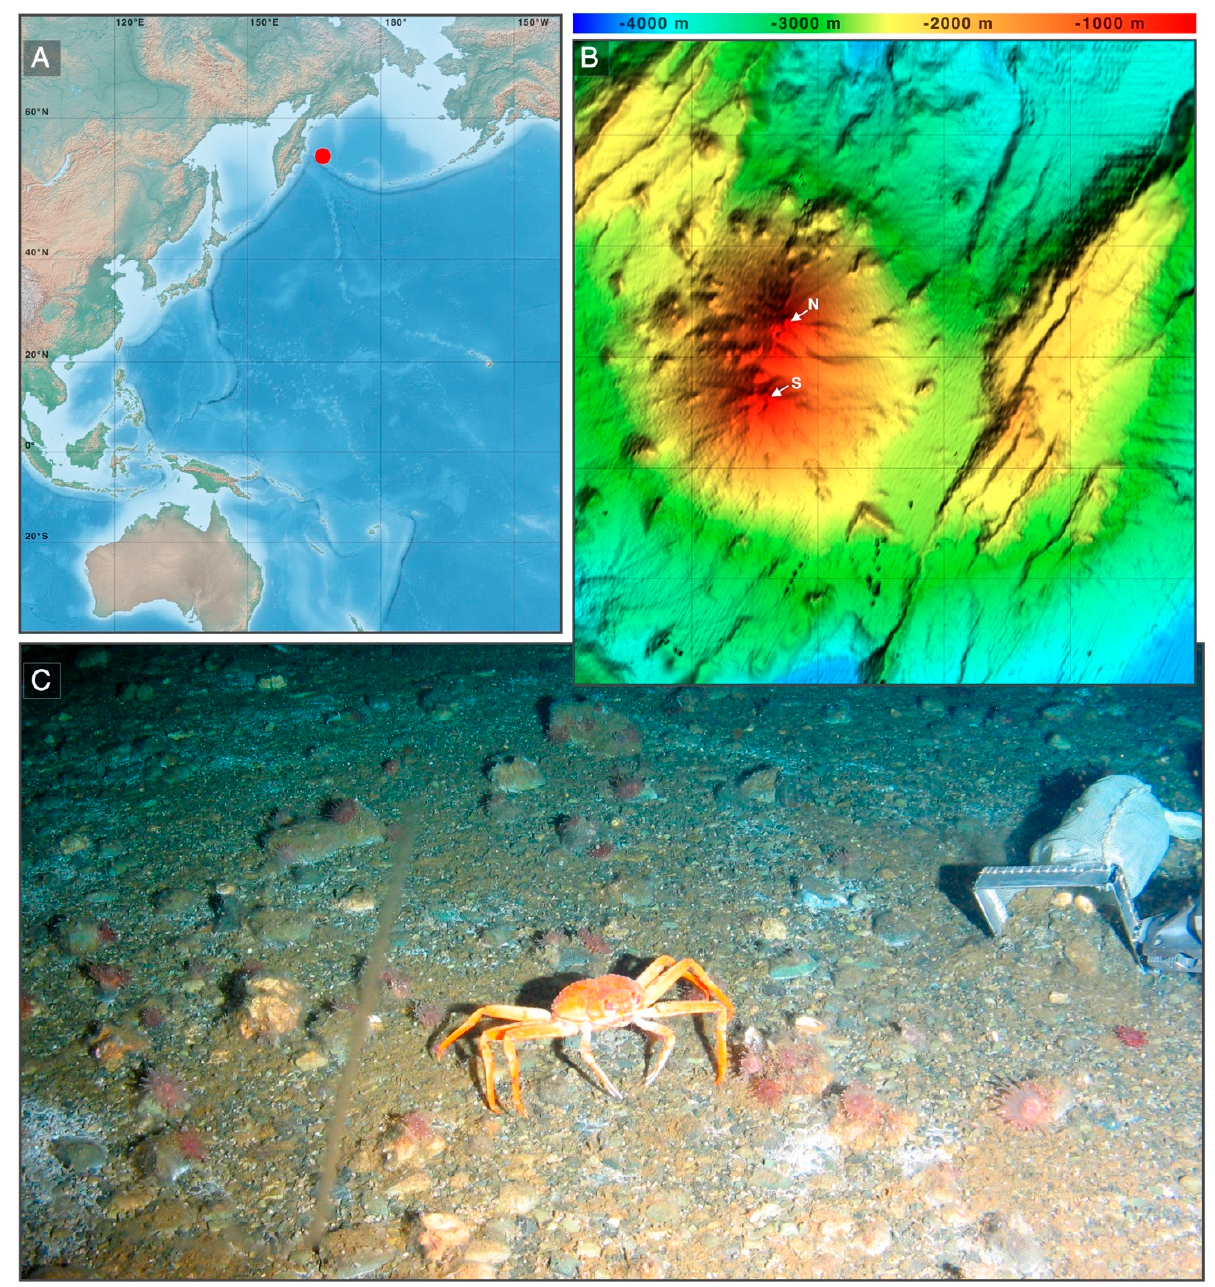
Figure 1. Sampling localities of new Provanna species. ( A ). General map of Western Pacific, red dot indicates Piip Volcano. ( B ). Bathymetrical map of Piip Volcano, arrows indicate southern (S) and northern (N) summits. ( C ). Type locality of new species on southern summit (LV82-8/3). Table 1. Sampling localities of provannid snails on Piip Volcano. Shells had been measured according to the scheme by Nekhaev